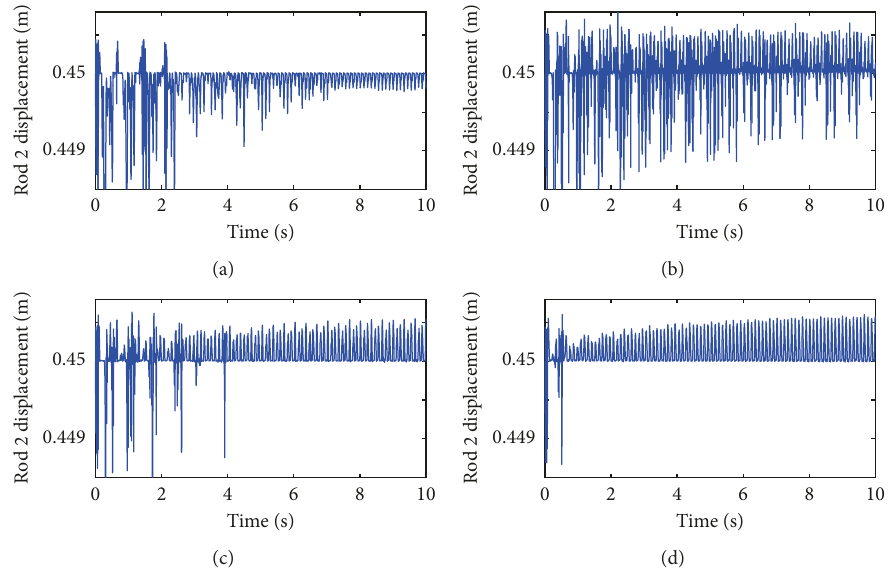
Figure 13: Displacement x 2 of rod 2 with different F max